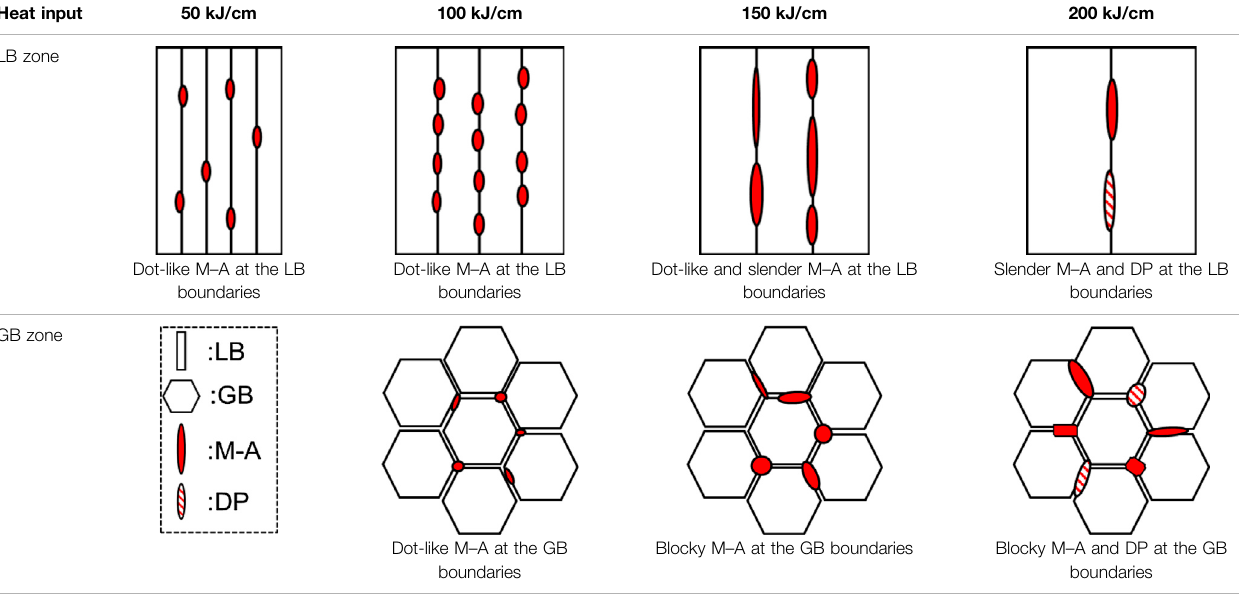
TABLE 1 | The transition in the microstructure and M – A constituents in the CGHAZ at the heat input of 50, 100, 150, and 200 kJ/cm. Heat